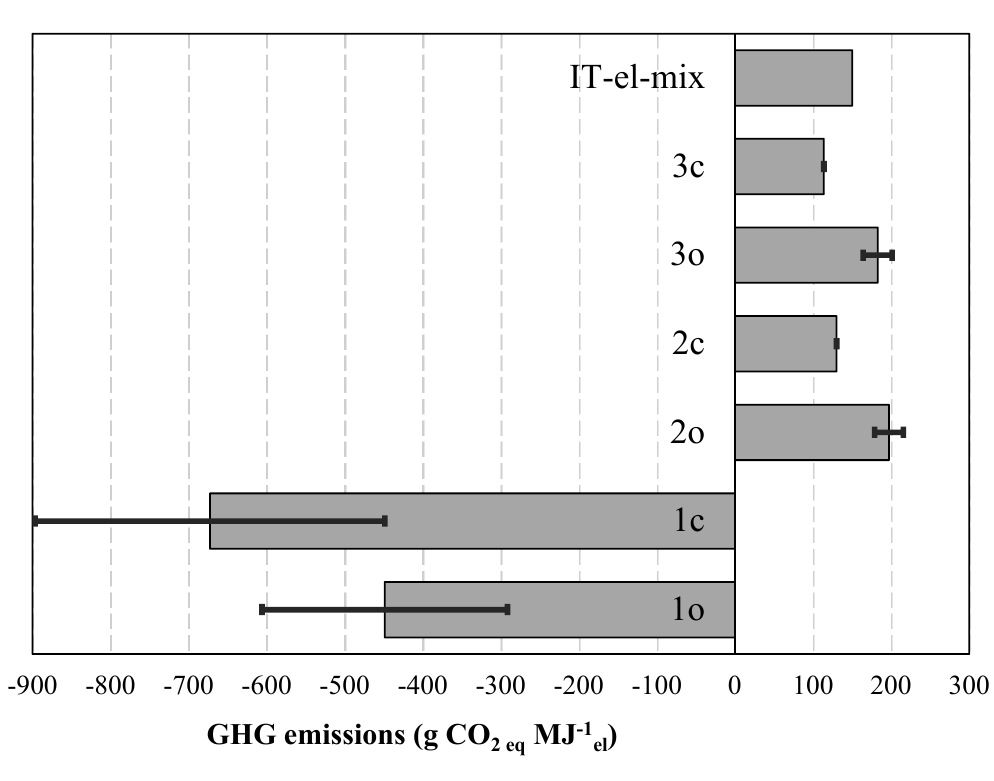
Figure A2. Results of the assessment of the sensitivity of the total GHG emissions to the variability of digestate and manure storage emissions. The grey bars represent the total GHG emissions of the analysed systems, the black error bars represent how the total GHG emissions range by varying the storage emissions by + or −